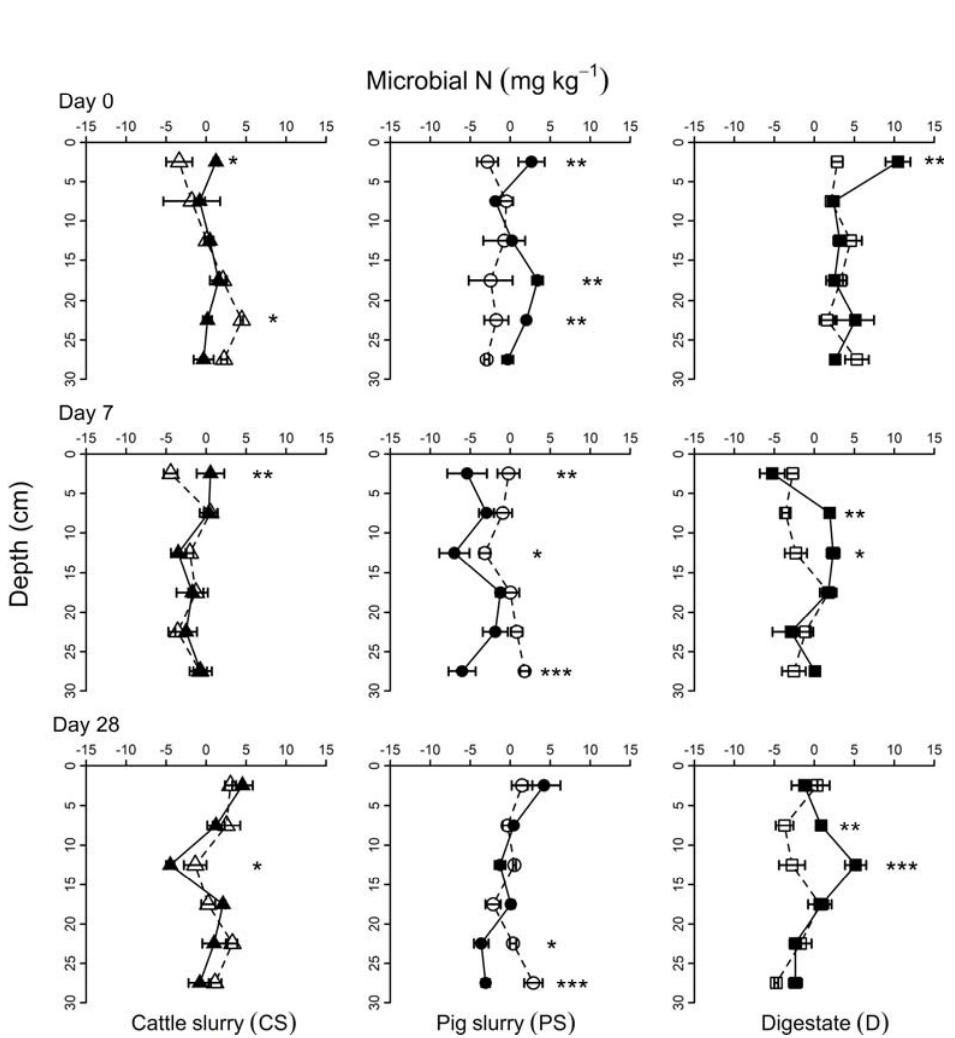
Figure 3. Net microbial N concentration in the soil columns with pig slurry ( ○ ); pig slurry plus N ‐ Lock TM ( ● ); cattle slurry ( ∆ ); cattle slurry plus N ‐ Lock TM ( ▲ ); digestate ( □ ); and digestate plus N ‐ Lock TM ( ■ ). Statistical significance of the differences according to HSD Tukey tests (* P ≤ 0.05; ** P ≤ 0.01; *** P ≤ 0.001).